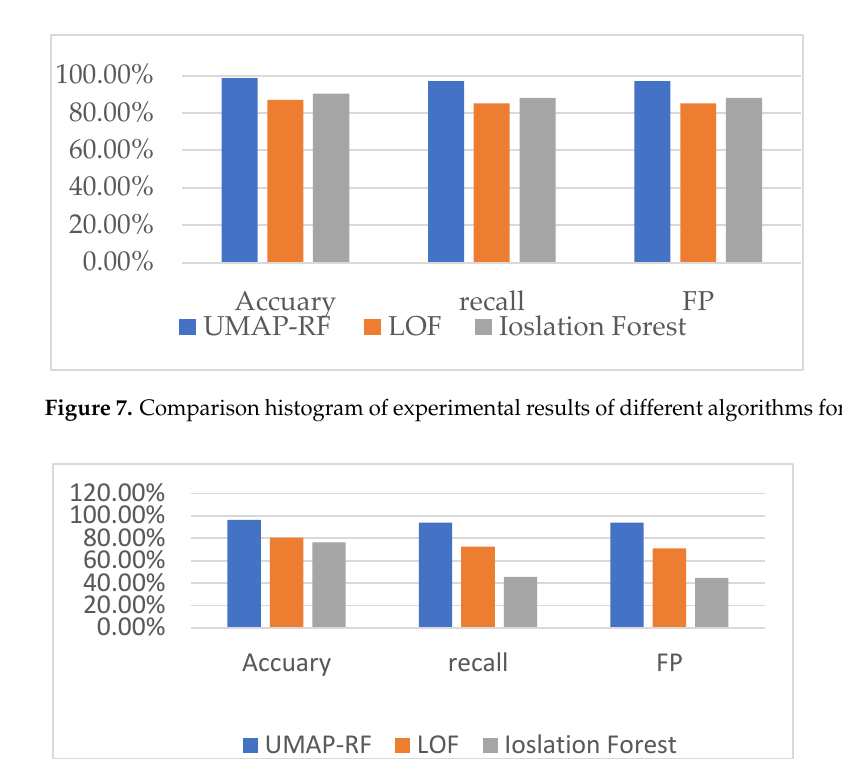
Figure 6. Visualization of binary classification effect based on hybrid algorithm UMAP-RF.